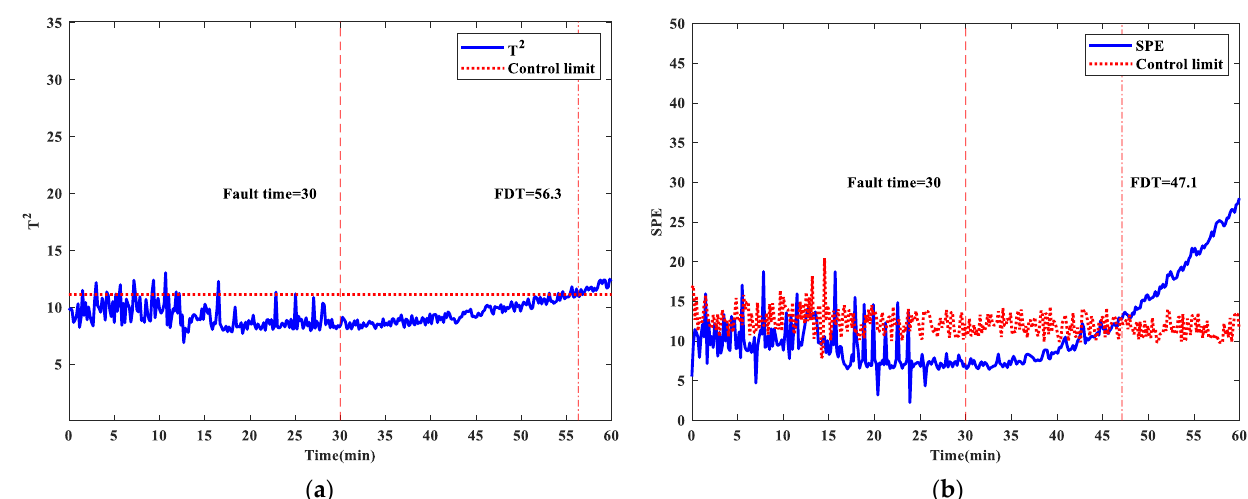
Figure 4. Fault monitoring charts of F2 based on MPCA: ( a ) 𝑇 2 monitoring chart; ( b ) SPE monitoring chart.